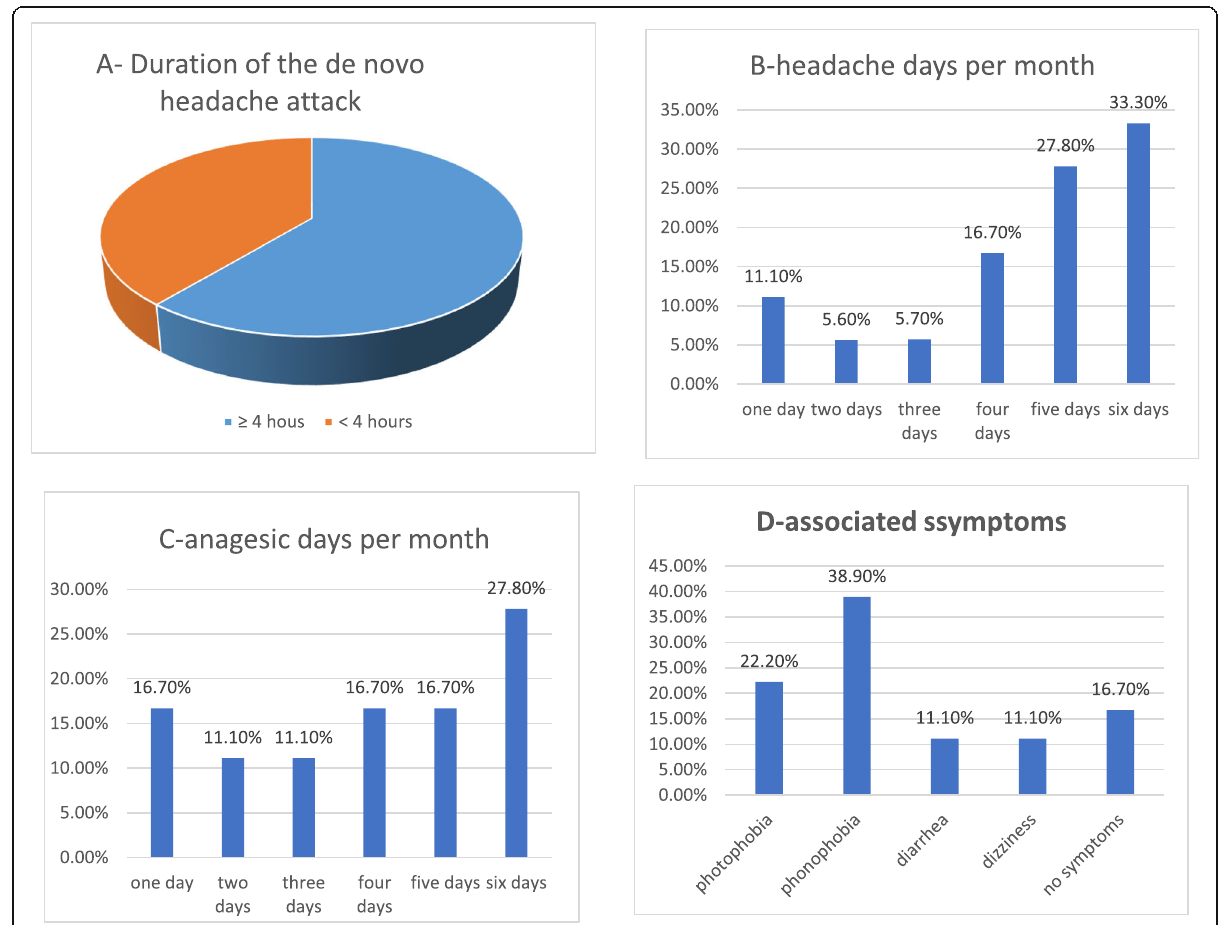
Fig. 3 The characteristics of de novo headache; ( A ) Attack duration ( B ) Headache days per month, C days of analgesic use per month,( D ) associated symptome of the headache